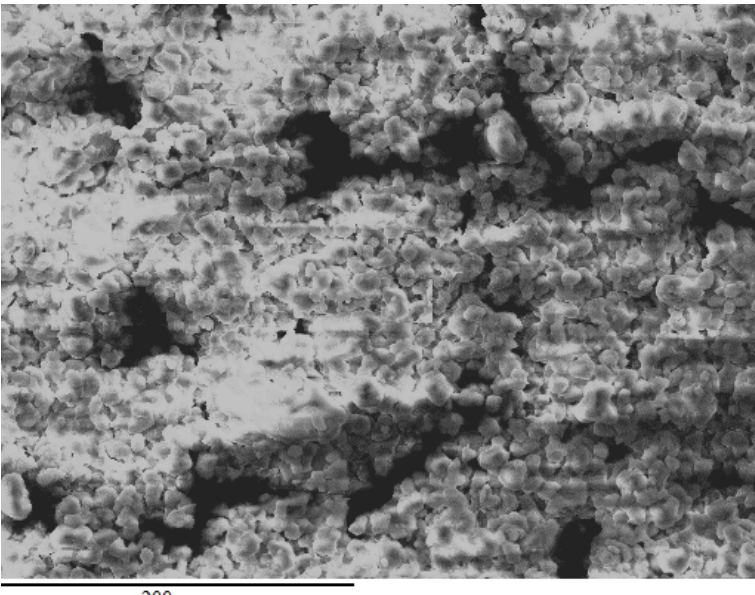
Figure 8. SEM image of the Fe-Cr-Al foil surface with supported secondary carrier and indication of the regions (points) in which the local elemental composition was determined. the regions (points) in which the local elemental composition was